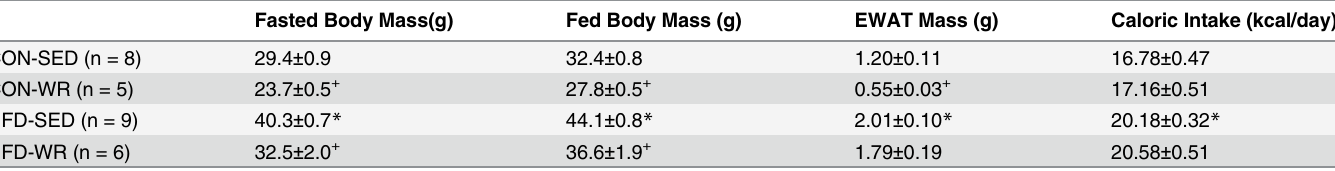
Table 1. The effects of a high fat diet and voluntary wheel running on body mass, epididymal white adipose tissue (EWAT) mass, and caloric intake. Fasted Body Mass(g)